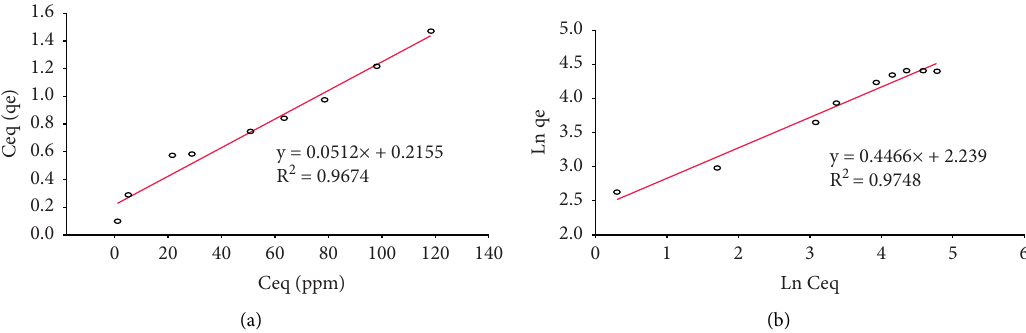
Figure 4: Te linear form of Zn(II) adsorption by D. tsuruhatensis SA-101: (a) Langmuir adsorption isotherm; (b) Freundlich adsorption isotherm. Table 2: Freundlich and Langmuir adsorption isotherm constants for Zn(II) biosorption by D. tsuruhatensis SA-101. Freundlich